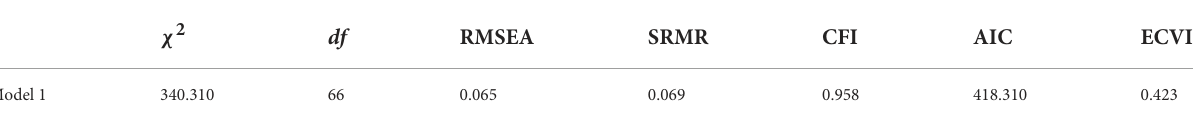
TABLE 2 Fit indices of structure Model 1.